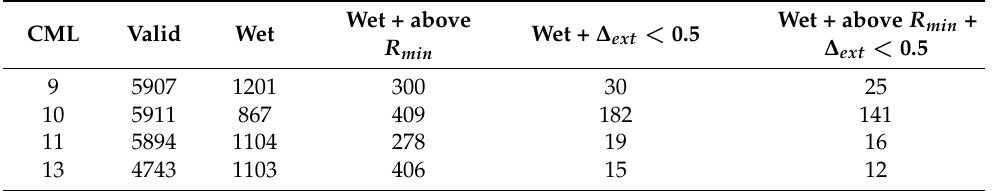
Table 5. Population of 10 min time slots in the observation period (6063 slots) and their classification according to the set of RG+DIS associated with each CML.